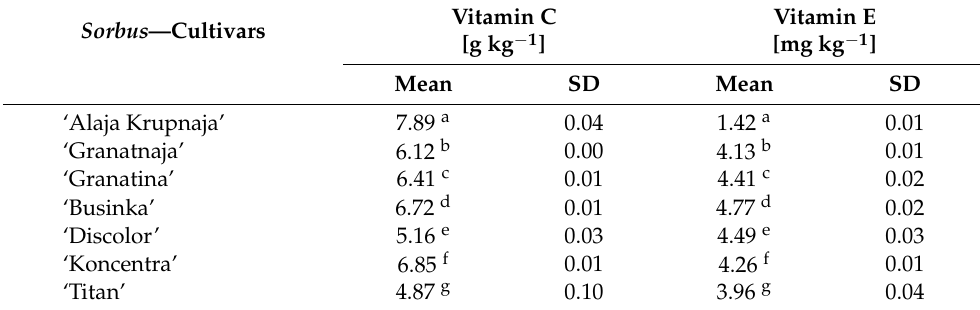
Table 8. The content of vitamins C [g kg − 1 ] and E [mg kg − 1 ] in the selected Sorbus cultivars.